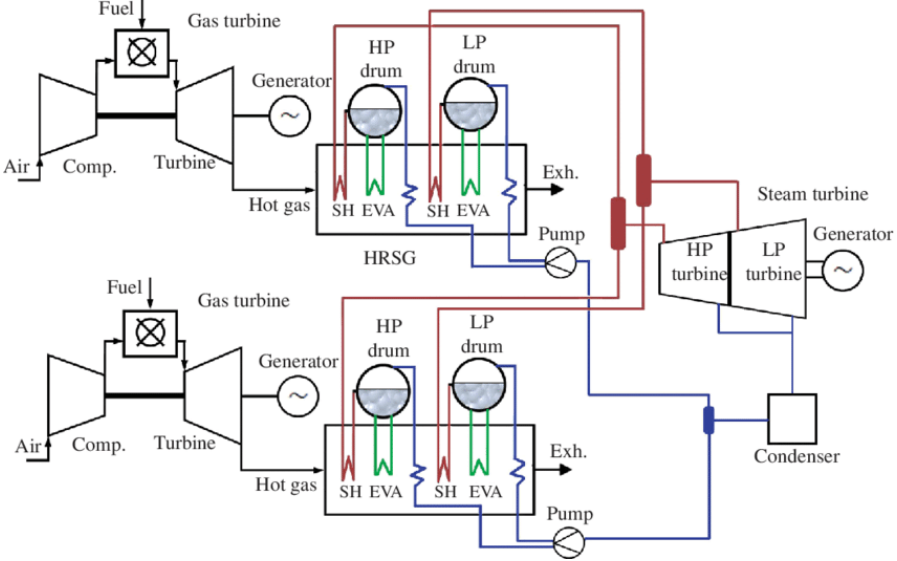
Figure 1. CCGT with two GTs and one ST.